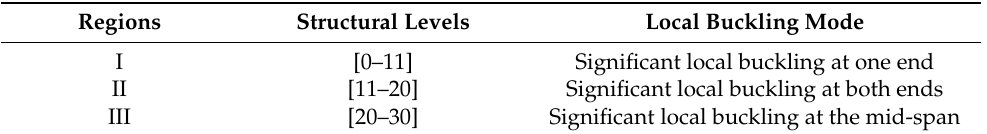
Table 15. The 3 characteristic local buckling regions.